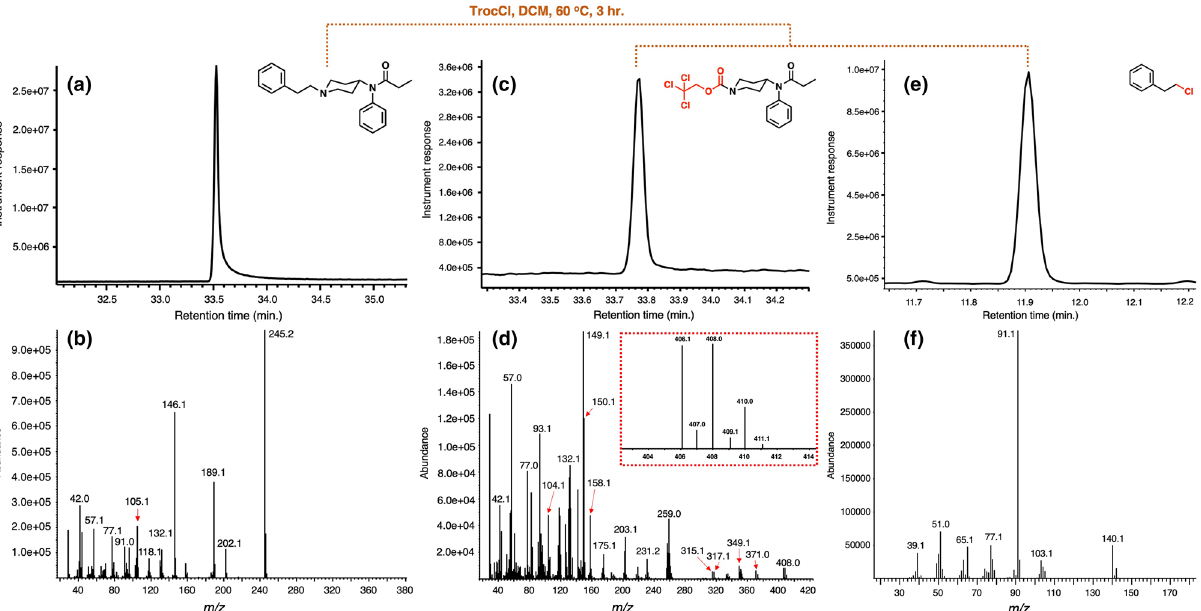
Figure 4. Trichloroethoxycarbonylation of fentanyl using optimized reaction conditions. ( a ) GC chromatogram of fentanyl (free base, rt = 33.5 min.; ( b ) mass spectrum of fentanyl; ( c ) GC chromatogram of first reaction product, Troc-norfentanyl (rt = 33.7 min.); ( d ) mass spectrum of Troc-norfentanyl showing isotopic pattern of its molecular ion peak in yellow inset; ( e ) GC chromatogram of second reaction product,